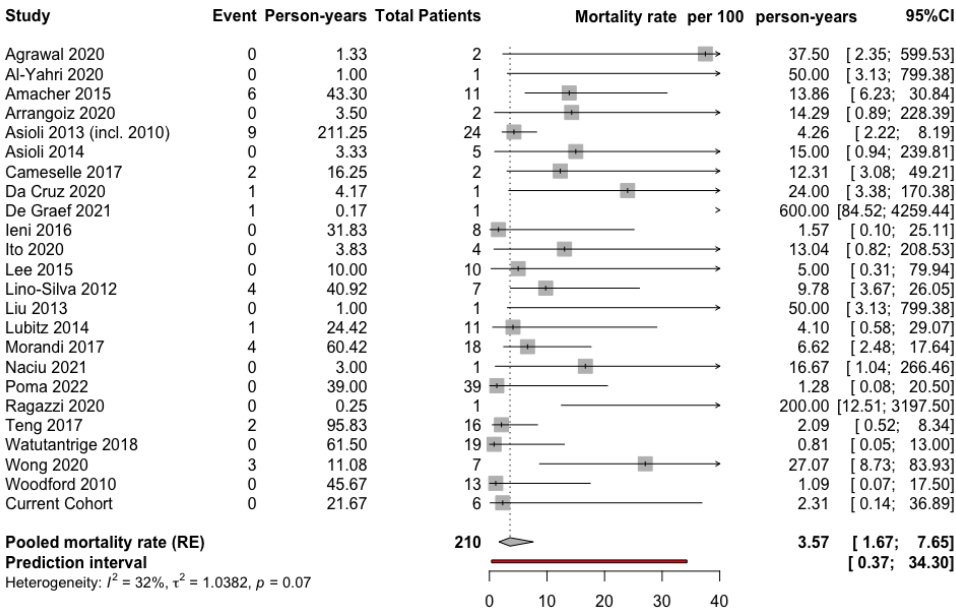
Figure 4. Forest plot demonstrating the mortality rate (in years) in patients with hobnail